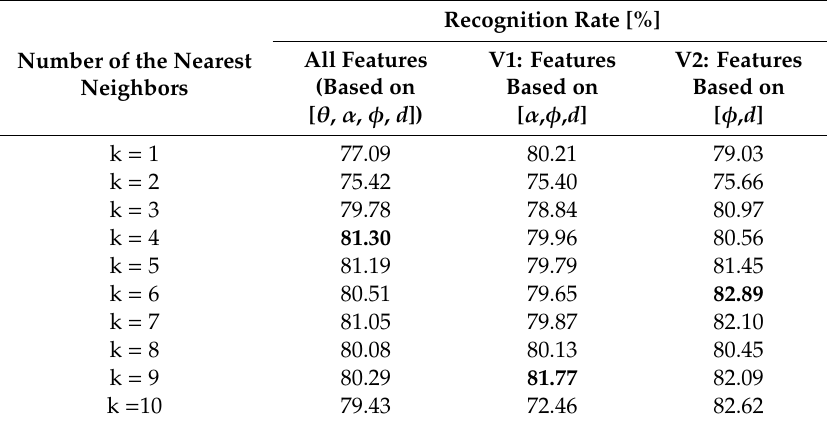
Table 9. Recognition rates for the MSR Action 3D dataset and two variants of feature reduction (ten –fold cross-validation